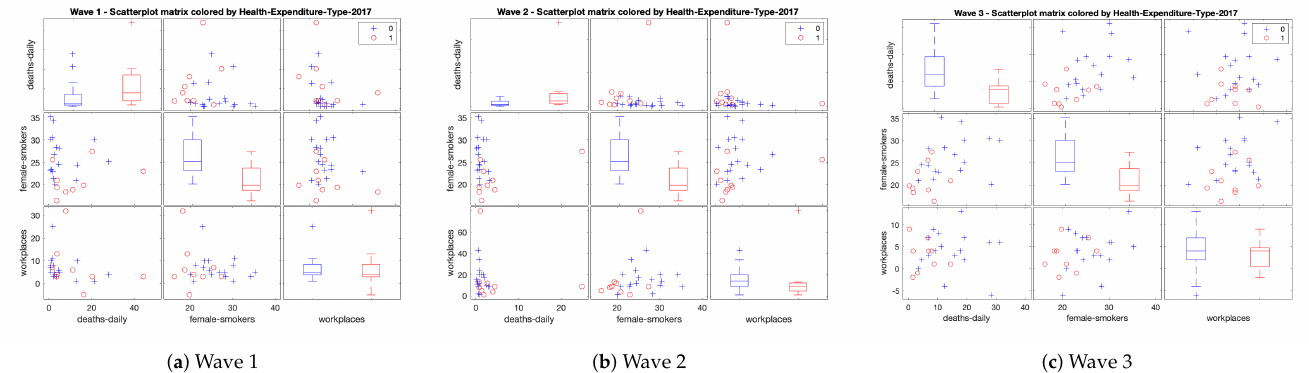
Figure 3. Exploratory step: Multiple scatter-plot for deaths_daily , female_smokers and workplaces_mobility , colored by Health_Expenditure_Type